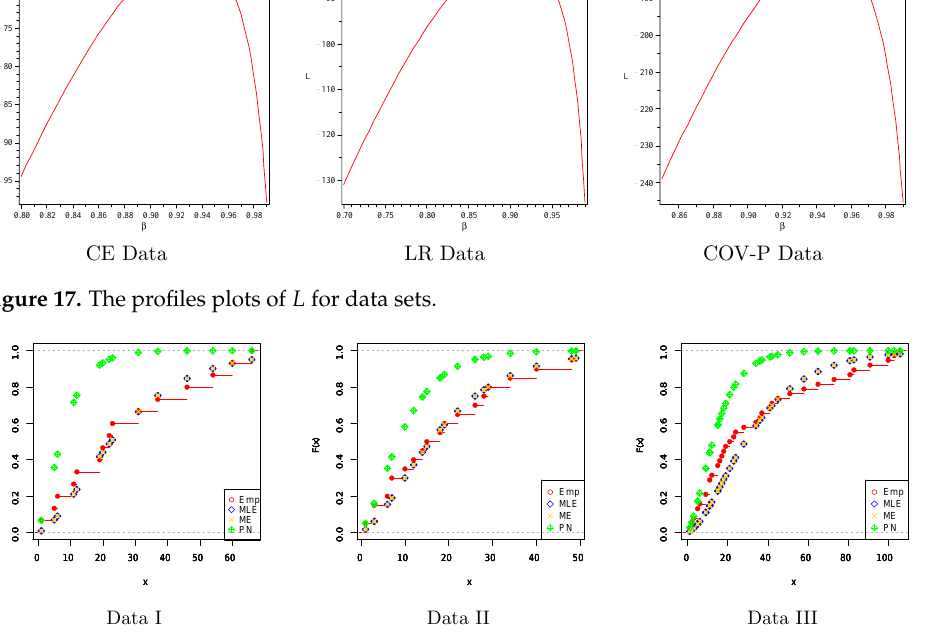
Figure 18. Empirical CDFs visualization plots for di⁄erent estimation methods.